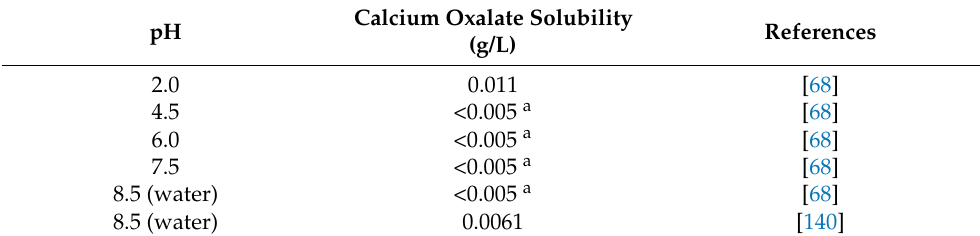
Table 6. Solubility of calcium oxalate at different pH values.